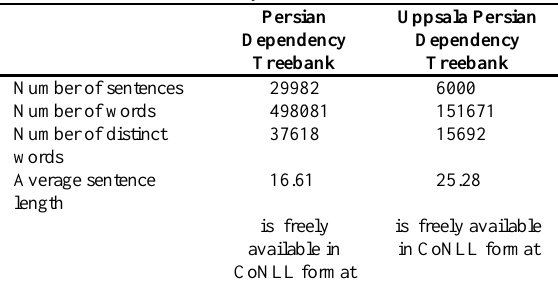
Table 2. Statistical Properties of PerDT and UPDT.